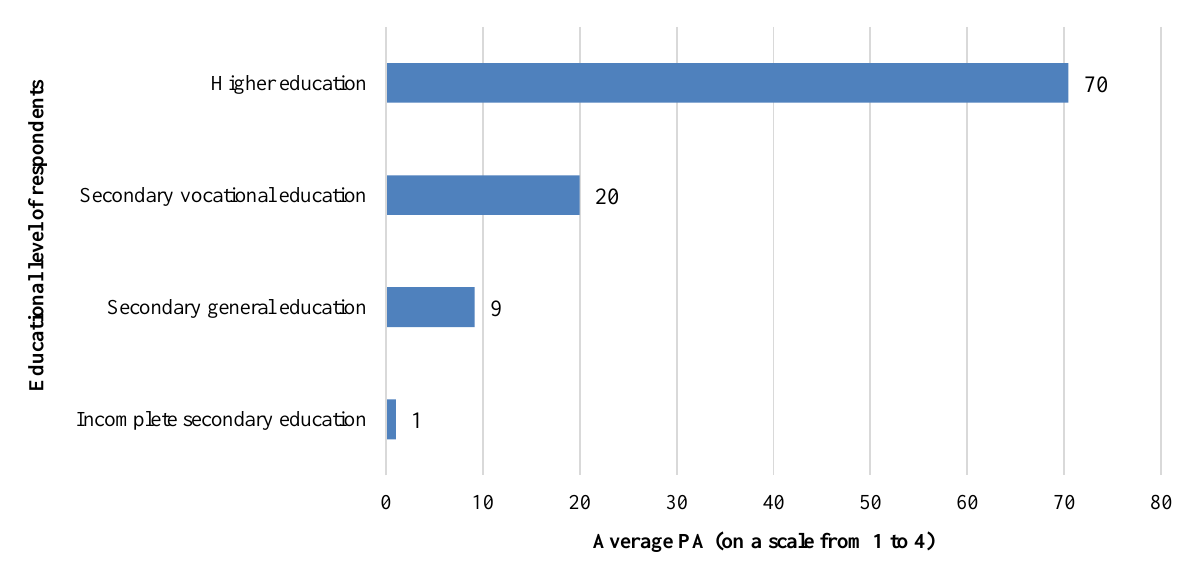
Figure 4. The educational level of